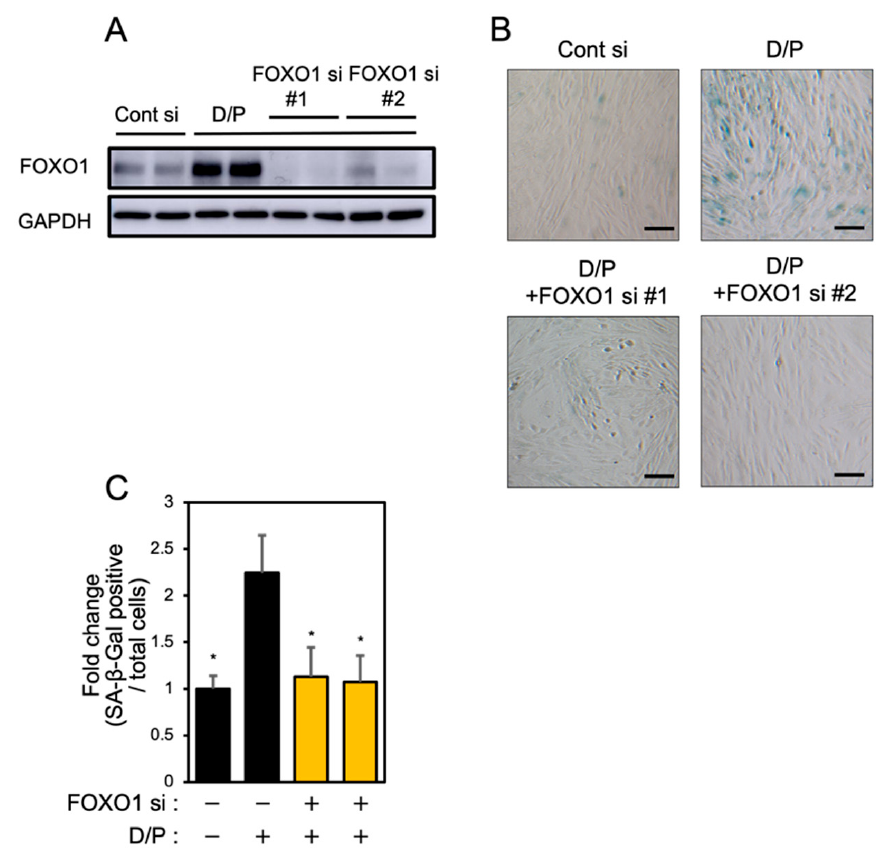
Figure 4. FOXO1 knockdown suppresses decidual senescence in ESCs. ESCs were transfected with FOXO1 siRNA for 1 day and then stimulated with D/P for 2 days. ( A ) FOXO1 expression was determined by immunoblotting analysis. ( B ) ESCs were stained for SA- β -Gal. Scale bars = 100 µ m. ( C ) The graph shows the relative ratio of SA- β -Gal-positive cells to total cells. Yellow bars show FOXO1 siRNA transfected groups. Values represent mean ± SEM from three independent experiments. * p < 0.05 vs. D/P.